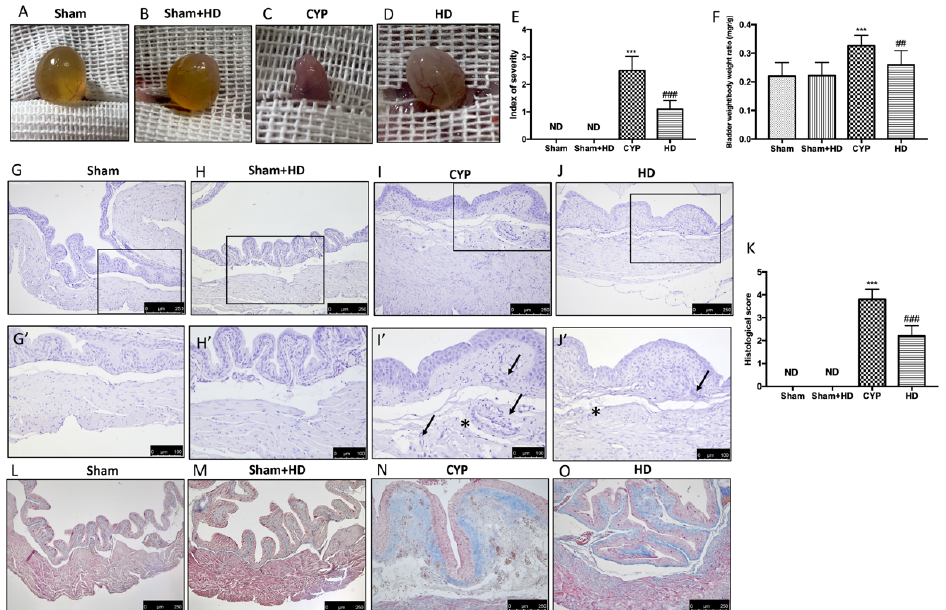
Figure 1. Effect of Hidrox ® (HD) on macroscopic and microscopic damage of bladder. Macroscopic damage in Sham mice ( A , E ), Sham + HD mice ( B , E ), mice with injection of CYP ( C , E ) and mice treated with HD ( D , E ). ( F ) Bladder weight/body weight ratio. Histological evaluation ( H , E staining): Sham mice ( G , G’ , K ), Sham + HD group ( H , H’ , K ), CYP group ( I , I’ , K ), and HD group ( J , J’ , K ). Symbols used in images I’ and J’ show edema (asterisk) and cell infiltration (black arrow). Fibrosis evaluation (Masson’s trichrome stain): Sham mice ( L ), Sham + HD ( M ), CYP mice ( N ), and HD mice ( O ). Values are means ± SD of five animals for each group; *** p < 0.001 vs. Sham; ## p < 0.01 vs. CYP; ### p < 0.001 vs. CYP; ND: not detectable.